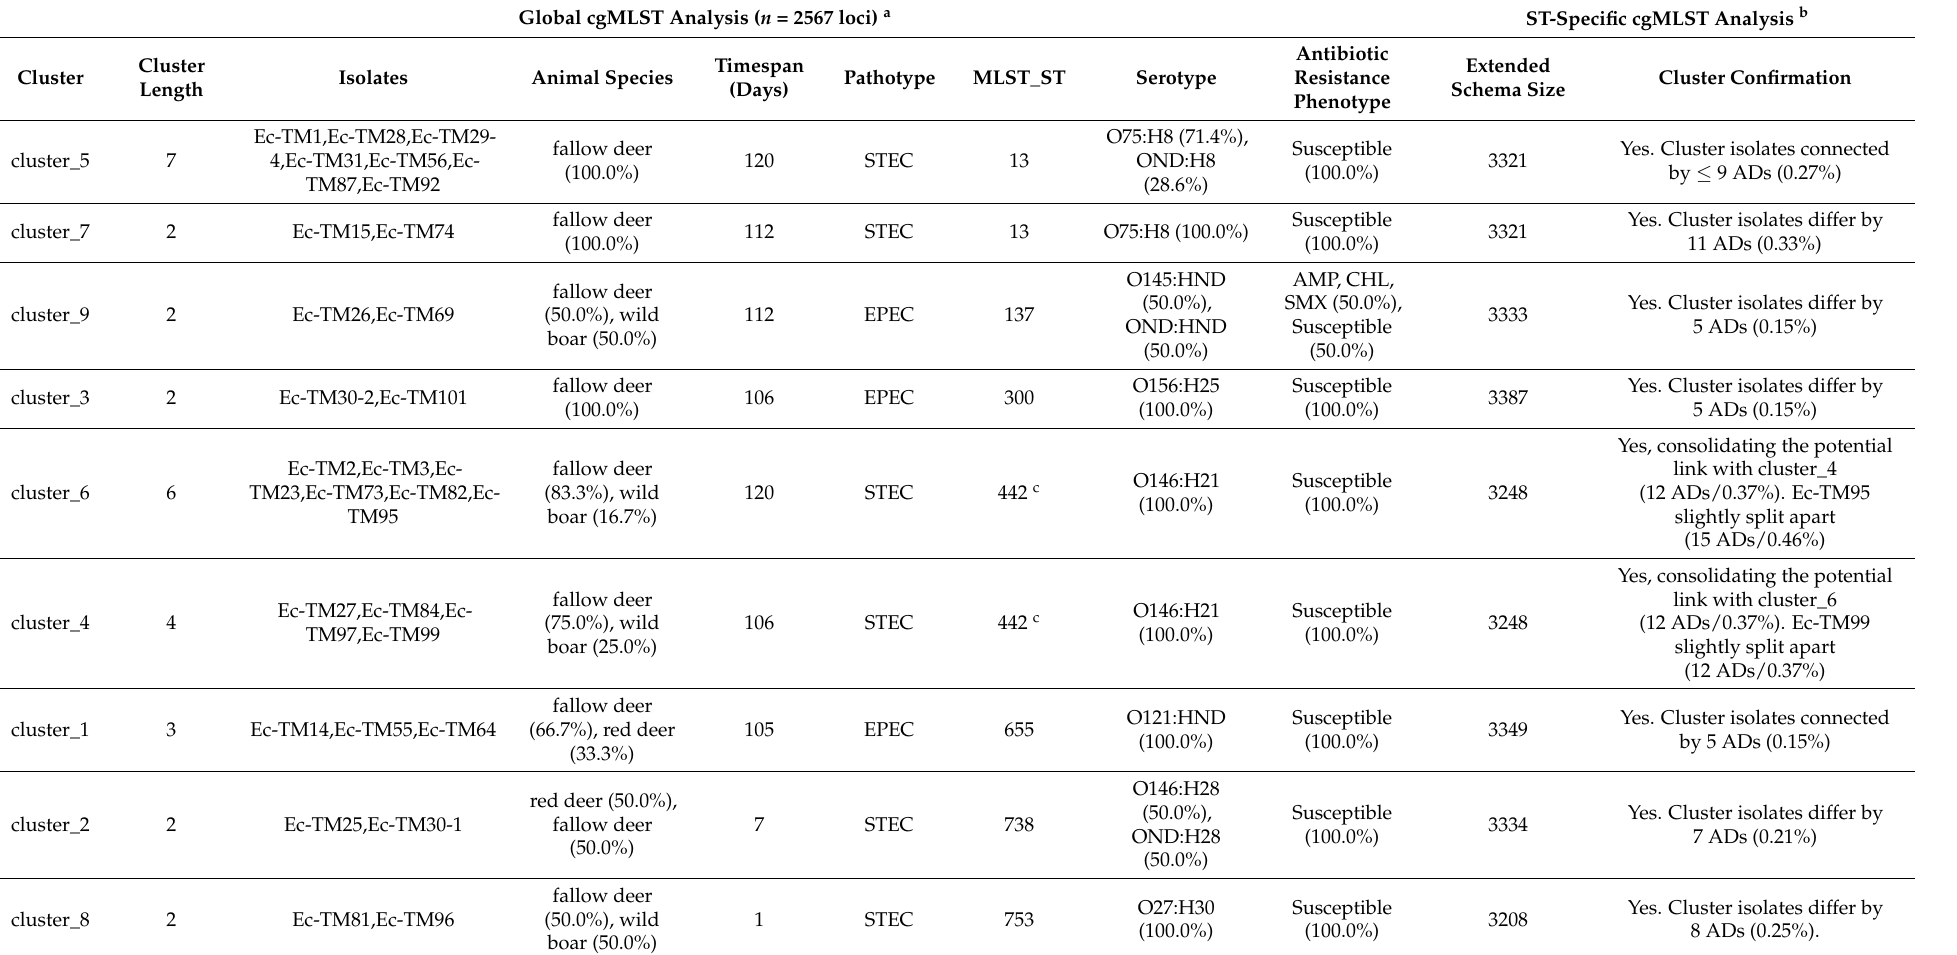
Table 3. Genetic clusters identified among pathogenic E. coli through cgMLST